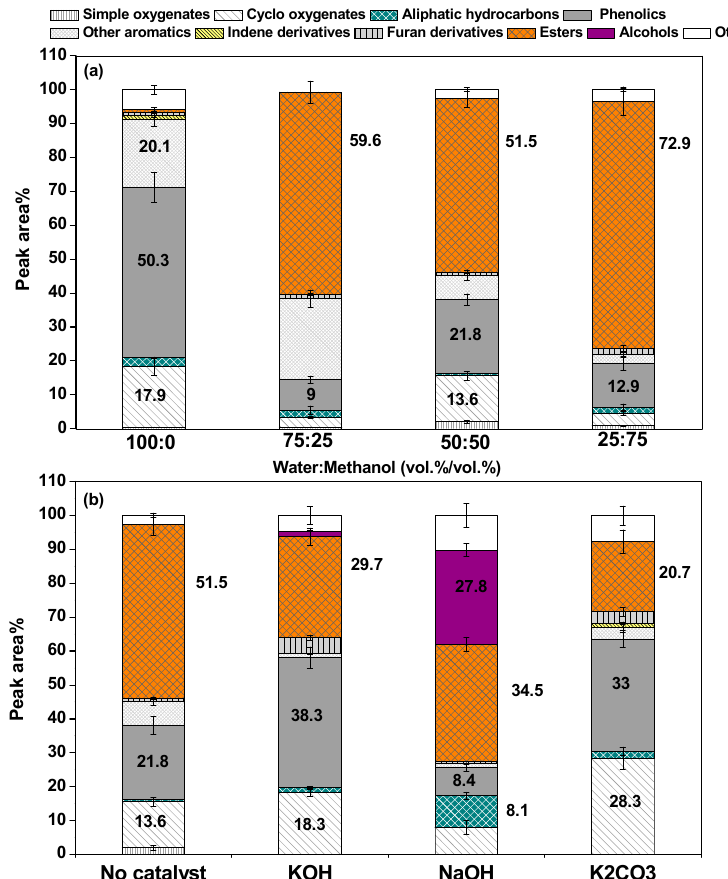
Figure7. Selectivitytovariousfunctionalgroupsinbio-crudeobtainedat( a )di ff erentwater-to-methanol ratios and ( b ) di ff erent alkali catalysts at water:methanol of 50:50 (vol.% / vol.%). The final temperature Figure 7. Selectivity to various functional groups in bio-crude obtained at ( a ) different water-to- is 300 ◦ C, reaction time is 60 min, and rice-straw-to-solvent ratio is 1:10 wt. / methanol ratios and ( b ) different alkali catalysts at water:methanol of 50:50 (vol.%/vol.%). The final temperature is 300 °C, reaction time is 60 min, and rice-straw-to-solvent ratio is 1:10 wt./wt.